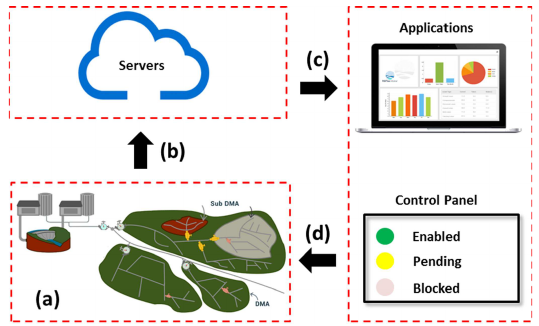
Figure 1. ( a ) Data collection; ( b ) data analysis; ( c ) monitoring (dashboard and alarms); ( d )